Question: What type of chart is this?
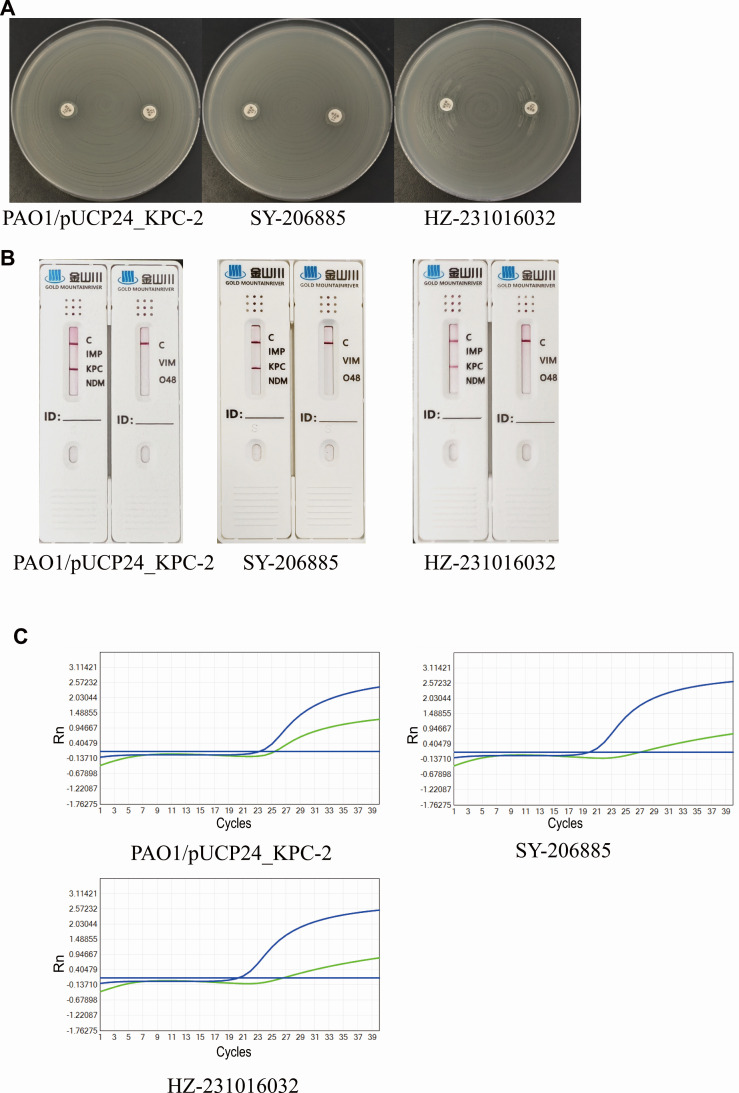
Answer: line